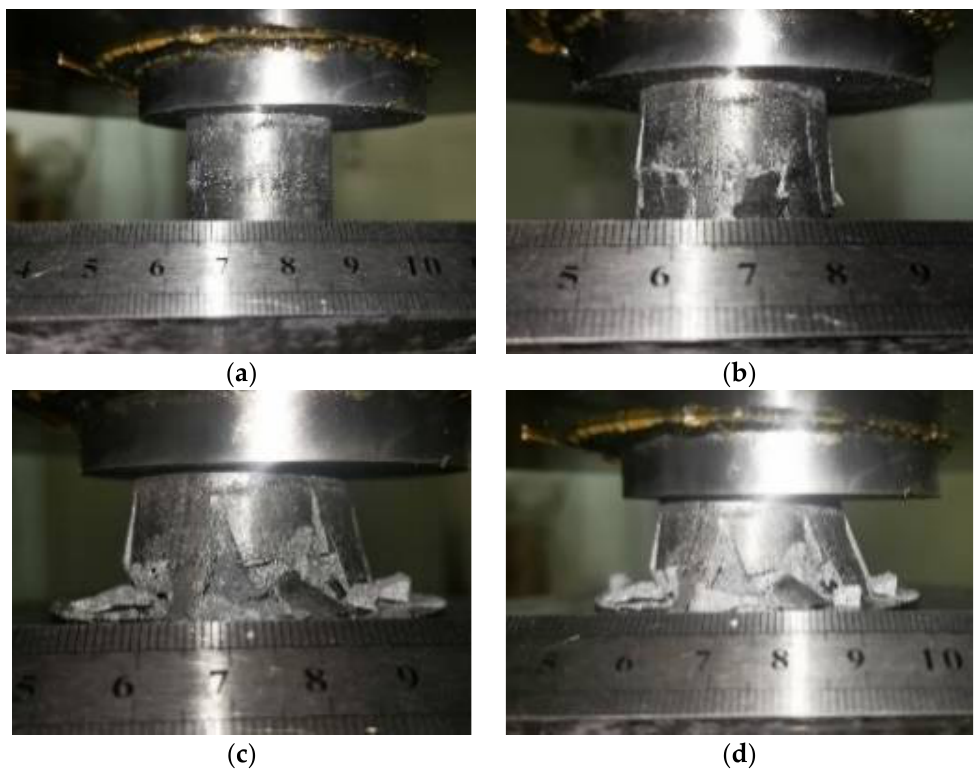
Figure 15. Quasistatic compression process diagram. ( a ) Initial stage; ( b , c ) Intermediate stage; ( d ) Final stage.